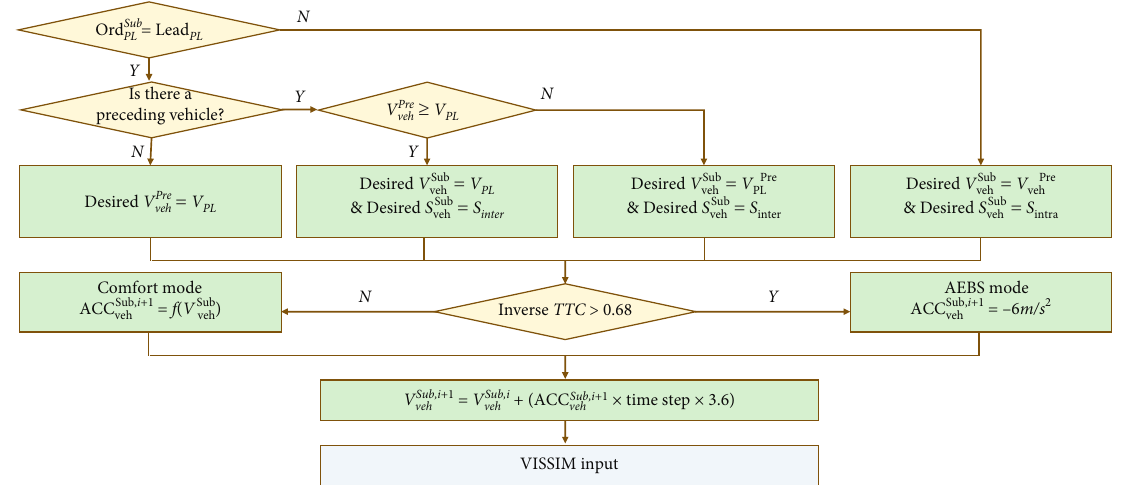
Figure 2: Proposed platoon formation